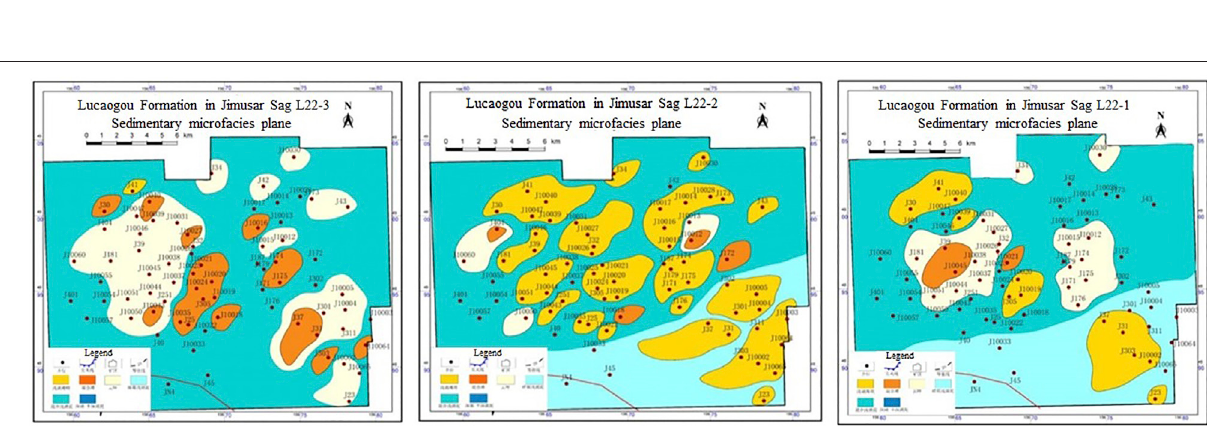
FIGURE8 | Sedimentary microfacies plane distribution in the lower sweet spot ofthe Lucaogou Formation in the Jimsar Sag. (A) sedimentary microfacies plane of P